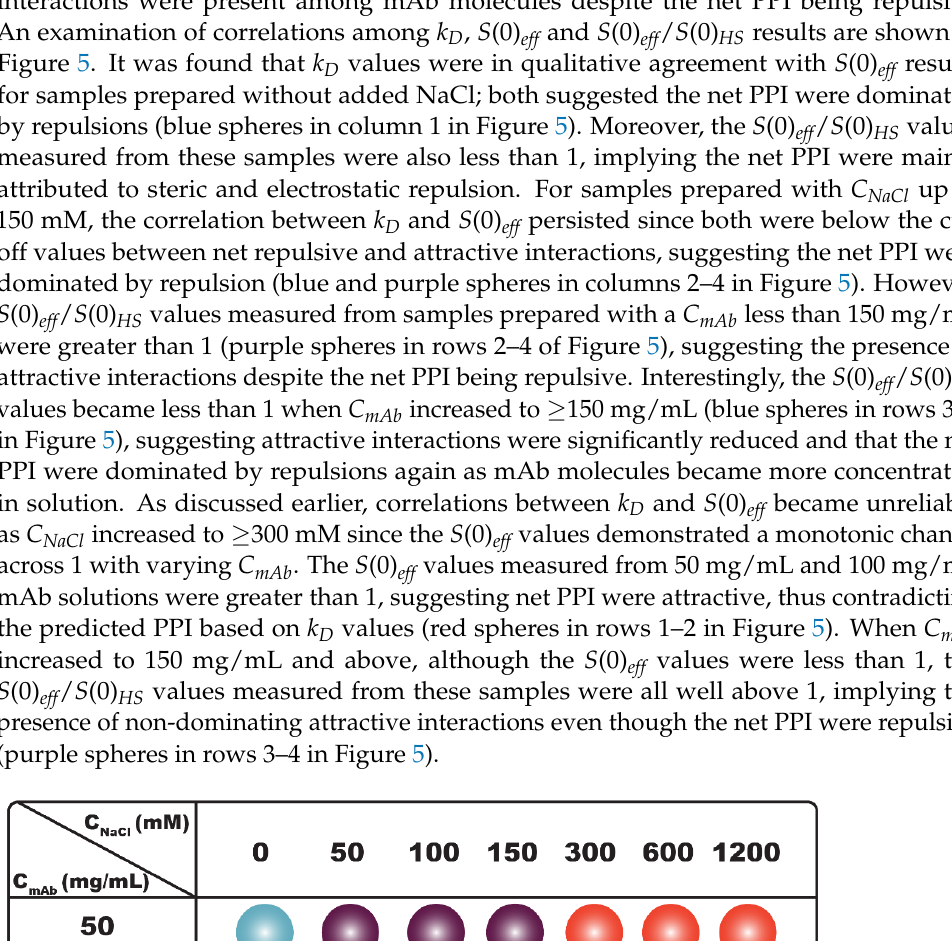
Figure 5. Correlations between k D , S (0) eff and S (0) eff / S (0) HS ratios. Conditions under which k D is greater than − 8 mL/g and S (0) eff as well as S (0) eff / S (0) HS values are less than 1 are represented with blue spheres. Under these conditions, all three parameters suggest the net PPI are repulsive. Conditions under which k D is greater than − 8 mL/g, but S (0) eff as well as S (0) eff / S (0) HS values are greater than 1 are represented with red spheres. Under these conditions, k D values suggest net PPI are repulsive, but S (0) eff values suggest the net PPI are dominated by attractions. Conditions under which k D is greater than − 8 mL/g, S (0) eff is less than 1, but S (0) eff / S (0) HS is greater than 1 are represented with purple spheres. Under these conditions, both k D and S (0) eff suggest the net PPI are repulsive; however, the S (0) eff / S (0) HS ratio suggests the presence of non-dominating attractive interactions. Experimental conditions under which mAb samples are not prepared/measured are shown in